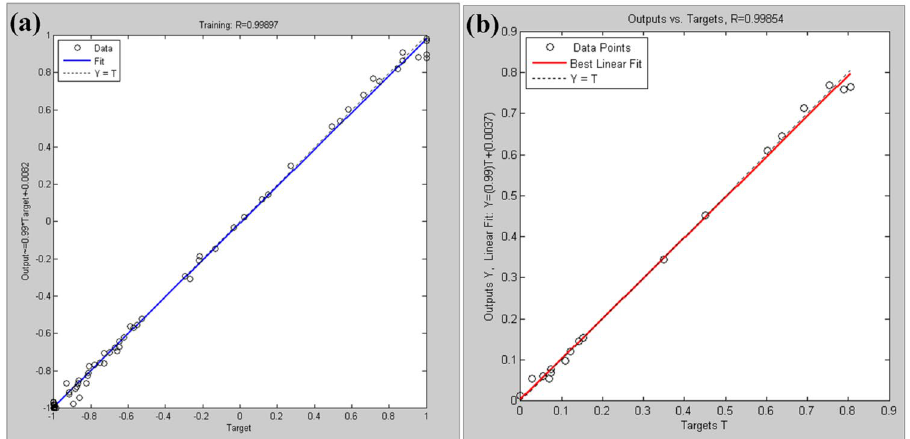
Fig. 5 a Regression plot for training data b Regression plot for testing